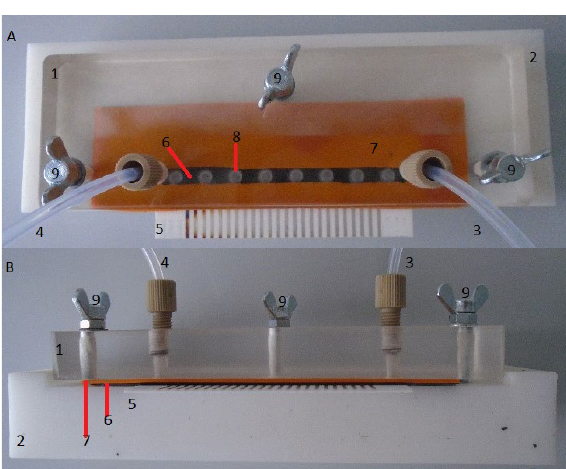
Fig. 1. Custom made flow cell (A) top view and (B) side view. Flow though cell consists of (1) cell top part, (2) cell nether part, (3) inflow tube, (4) outflow tube, (5) DropSens 550 screen-printed electrochemical array, (6) black distance piece, (7) orange silicone sealing, (8) membrane, (9) screw.